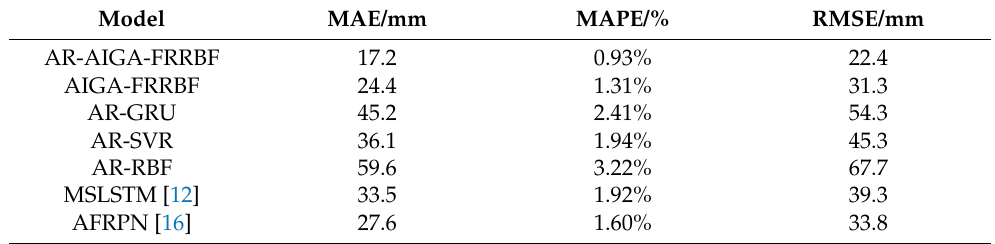
Table 13. Comparison of prediction performance of right drum height of shearer with different